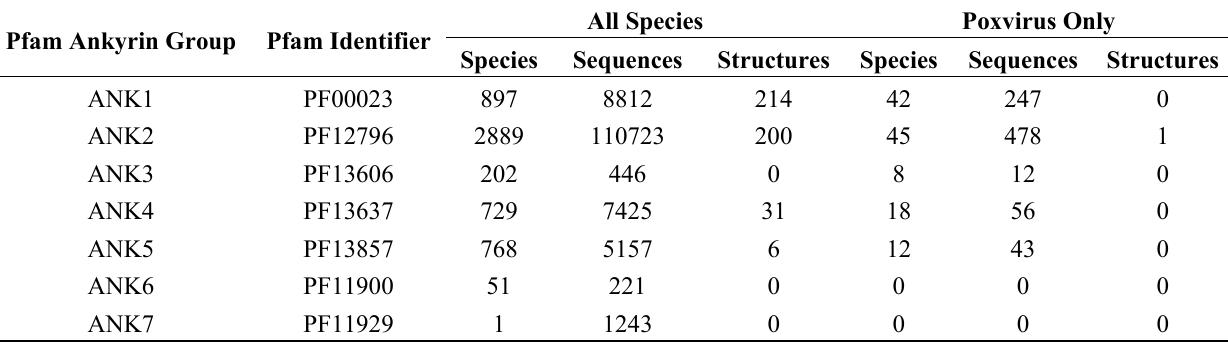
Table 1. Pfam ankyrin groups. The ankyrin repeat superfamily (Pfam clan CLO465)